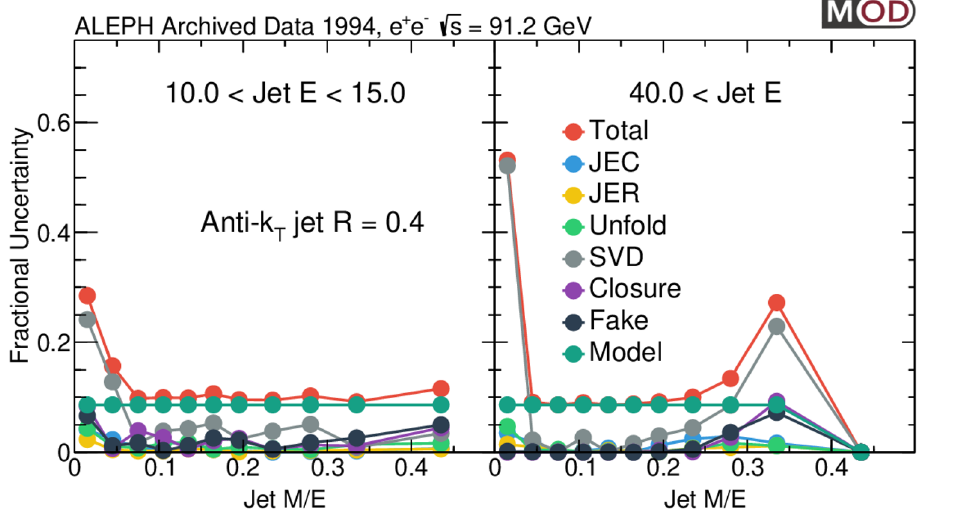
Figure 11 . Summary of the size of relative systematic uncertainty from different sources for M/E , in bins of jet E from 10–15 GeV (left panel) to above 40 GeV (right